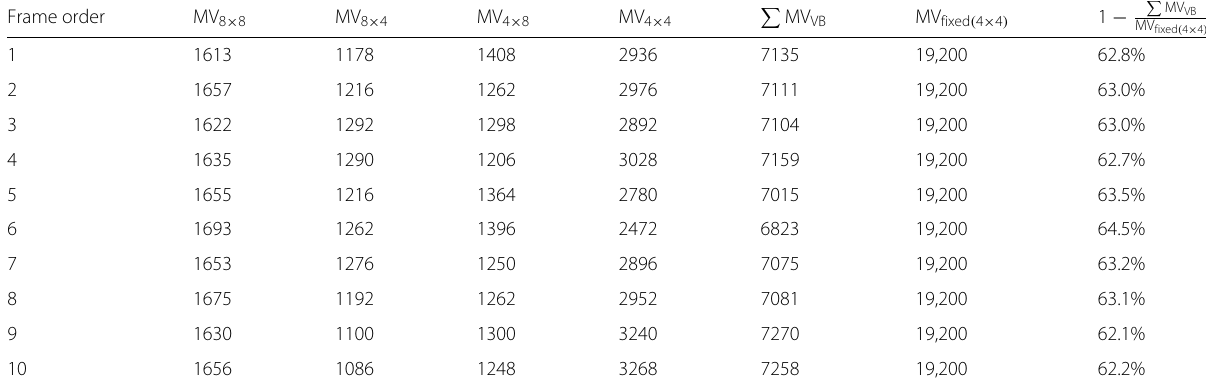
Table 8 Comparison of a number of MVs between variable- and fixed-size blocks (8 × 8, 8 × 4, 4 × 8, and 4 × 4) Frame